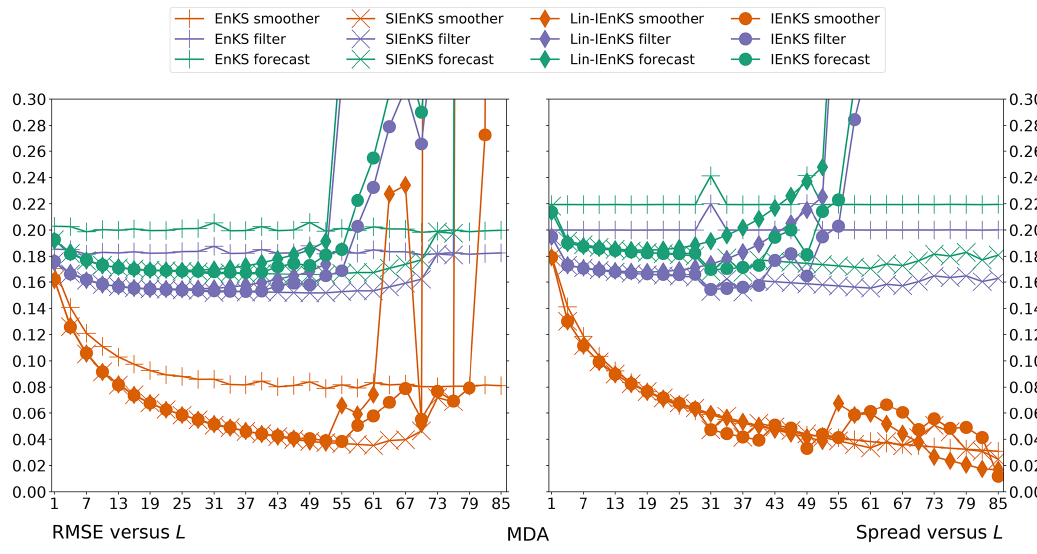
Figure 11. Cross section of Fig. 10 at the ensemble size N e = 21.